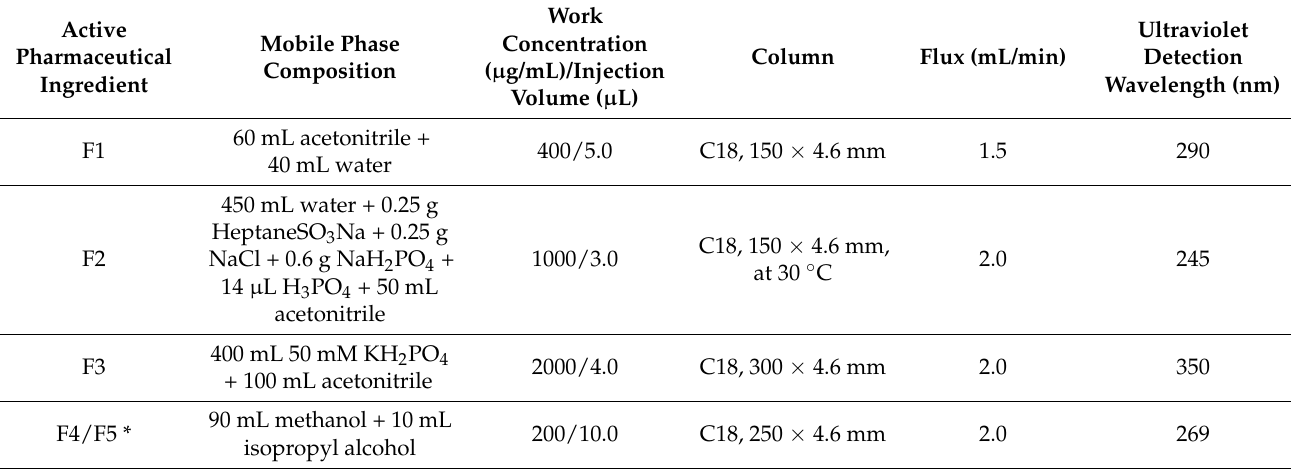
Table 2. Chromatographic conditions used in the compatibility study.